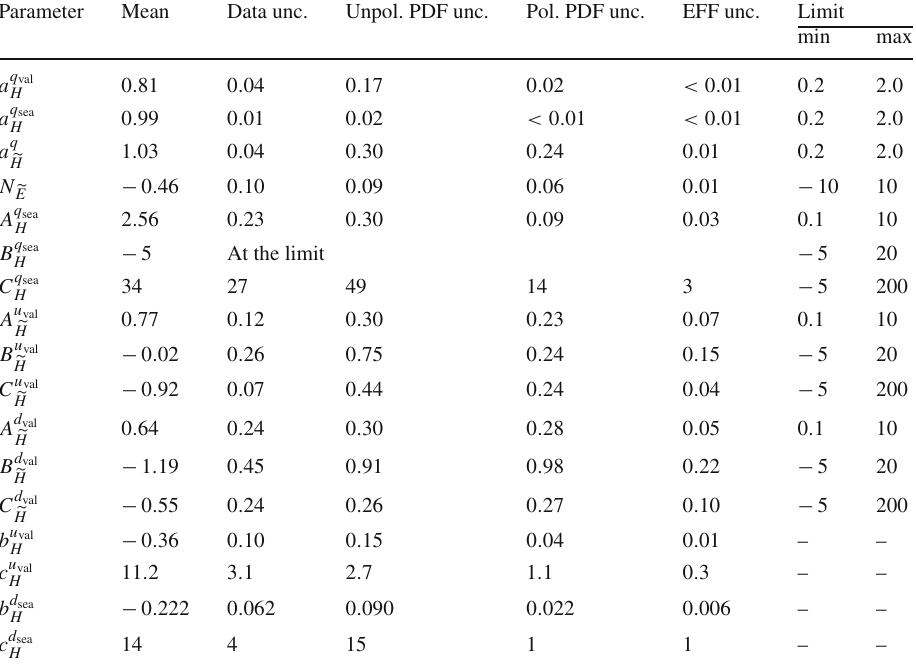
Table 5 Values of the parameters fitted to DVCS data together with estimated uncertainties coming from those data, (un-)polarized PDFs and EFFs. Two last columns indicate the limits in which the minimization routine was allowed to vary the corresponding parameters. In addition, exemplary values of b q and c q parameters evaluated G G at Q 2 = 2 GeV 2 from Eqs. (62) and (63) are